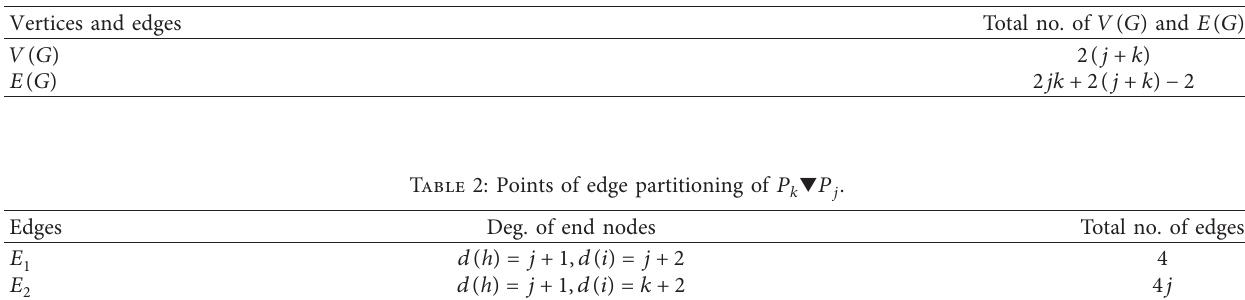
Figure 1: Indu-Bala graph P Table 1: Number of vertices of different degrees of Indu-Bala graph.